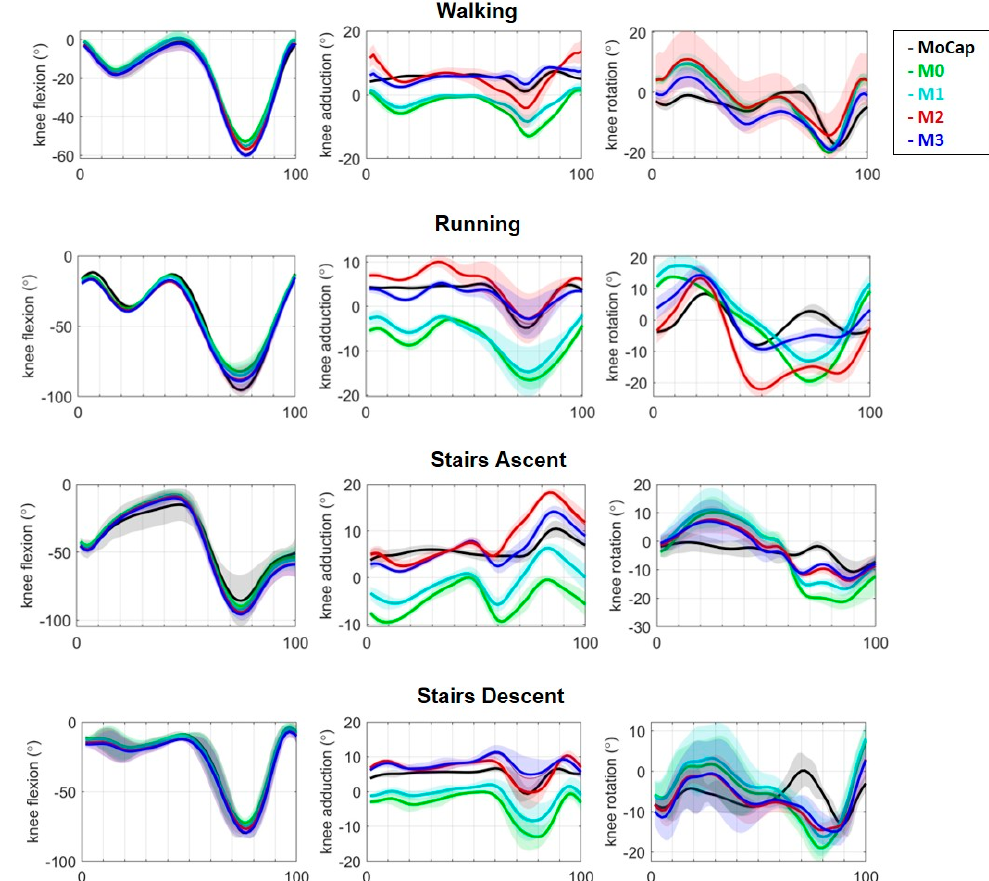
Figure 3. 3D knee joint angle comparison during walking, running, stair ascent, and stair descent over a cycle for a representative subject—in order sagittal, frontal, and transverse planes. InCap system (M0—green, M1—cyan, M2—red, M3—blue) and MoCap system (black). M0: OpenSense standard pipeline, M1: functional hip abd-adduction motion calibration, M2: functional PCA walking calibration, M3: functional hip abd-adduction and walking PCA calibration. Table 1. Values between calibration methods and MoCap during the different motions for knee joint. RMSE: root mean square error, R 2 : coefficient of determinationSD: standard deviation. Significant differences p < 0.05—values in bold. W: walking; R: running; S.A. stair ascent; S.D: stair